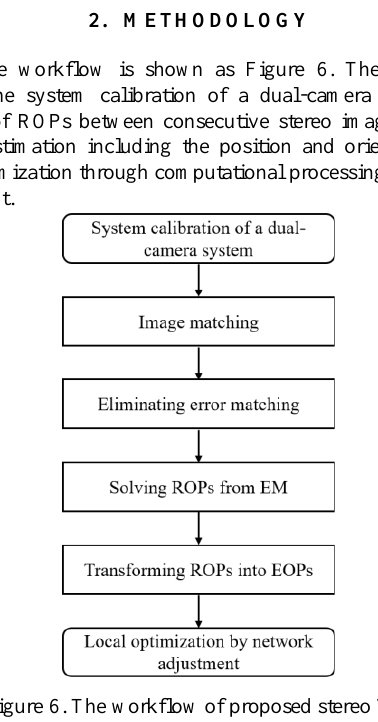
Figure 3. The geometric relationship of adjacent image pairs in stereo VO (Yoon and Kim, 2019).